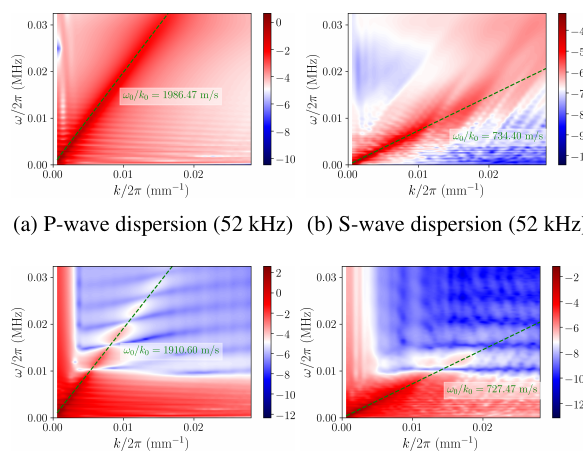
Figure 4: Wavenumber-frequency domain response and = 10 MPa and φ = the acoustic branches for σ (cid:48) 10 MPa c 0 . 6322. Color code indicates the DFT of the particle ve- locity in the longitudinal (a, c) and transverse (b, d) direc- Figure 5: Pressure–wave velocity relationships for di ff er- tions; dashed lines give the wave velocities (inset). ent initial volume fractions ( ω/ 2 π = 5 . 2